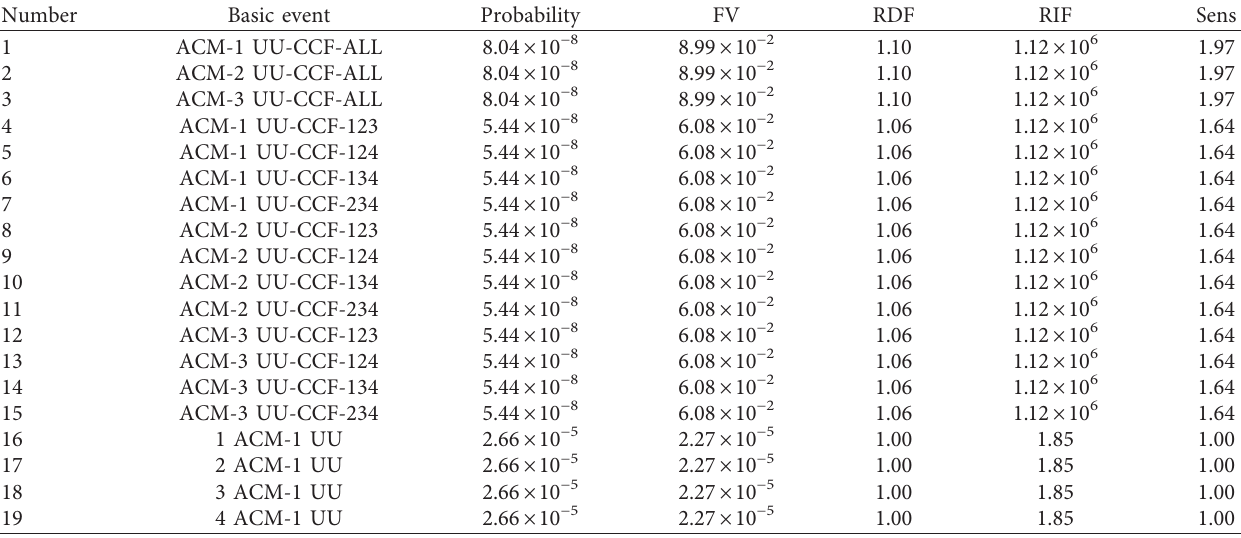
Table 5: Importance and sensitivity of the selected BEs on system